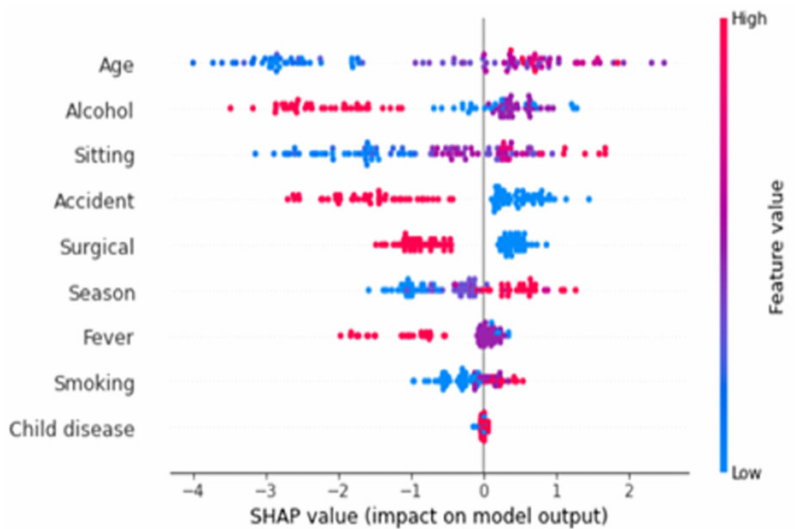
Figure 4. Global visual explanation of proposed system via